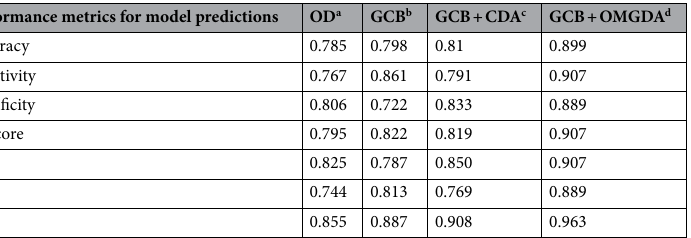
Table 1. Performance evaluation of internal test set for CheXNet model. a CheXNet model trained using original data, only. b CheXNet model trained with GAN-based class balancing. c CheXNet model trained with GAN-based class balancing and conventional data augmentation. d CheXNet model trained with the output of the suggested automation pipeline, which is the trained model of K optimal (GCB + OMGDA).